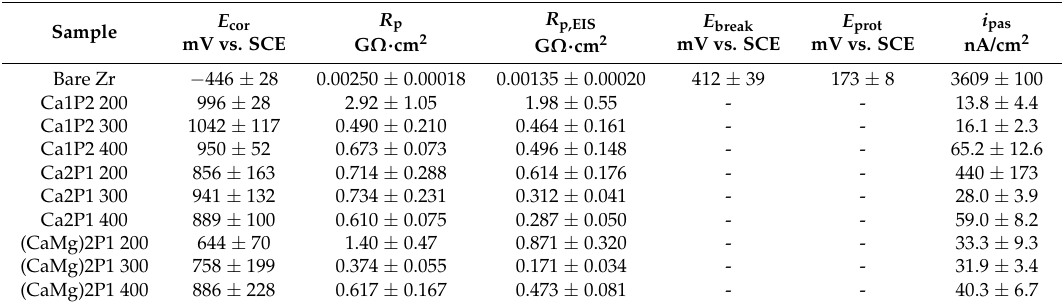
Table 2. Corrosion parameters of zirconium before and after the PEO obtained from the potentiodynamic polarization (PDP) and EIS studies in Ringer’s